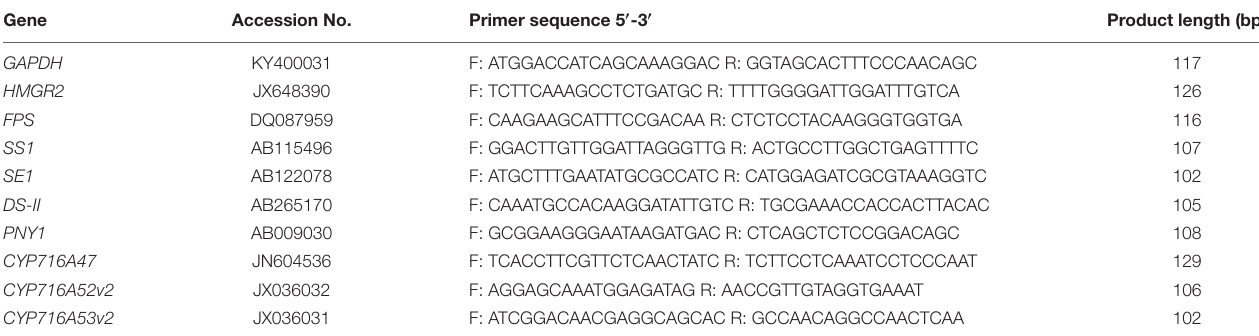
TABLE 1 | Real-time fluorescence quantitative PCR primers. Gene Accession